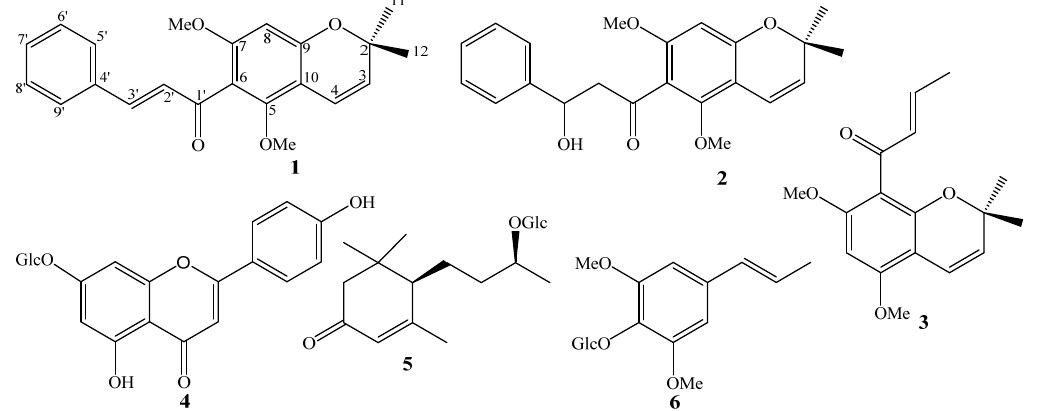
Figure 1. Chemical structures of compounds 1 – 6 .